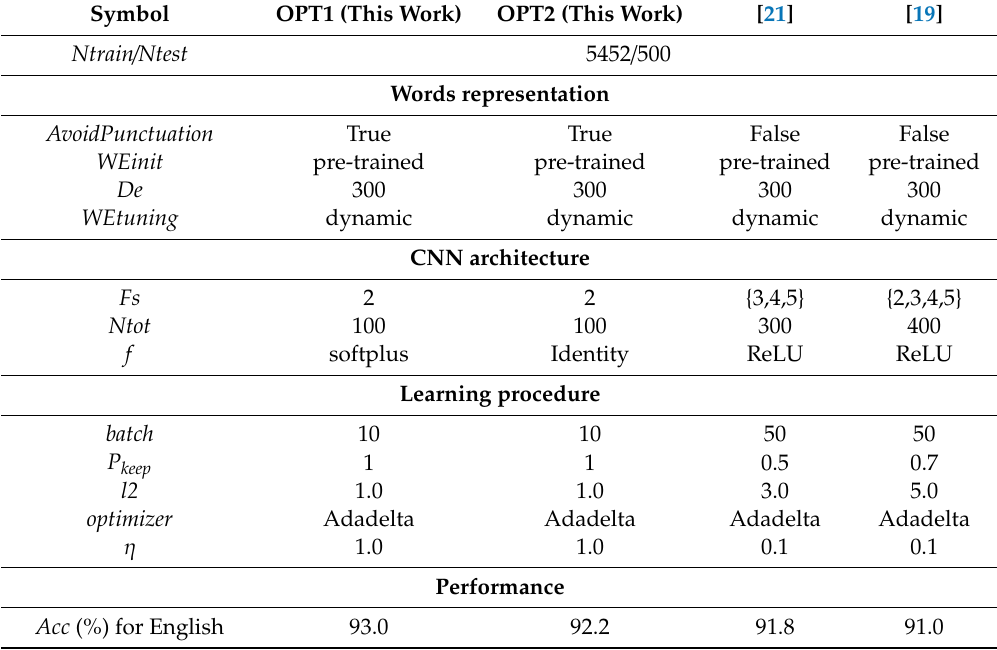
Table 19. Testing accuracy on [35] data with optimal settings, and with settings individuated in previous